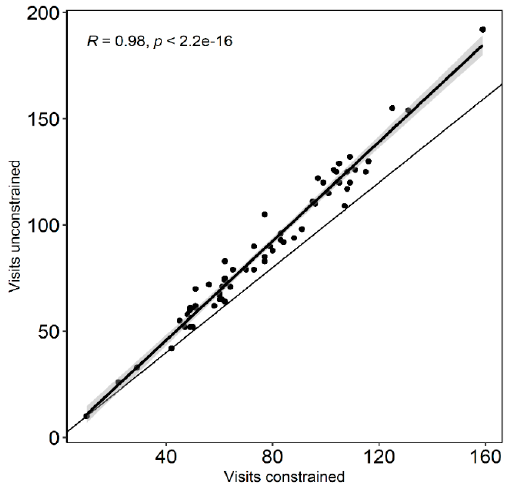
Figure A1. Relationship between total number of visits to flower-heads by hummingbirds including visits behind rocks (visits unconstrained) and the number based only on flower-head visits that could be easily seen (visits constrained). The data points are the sum of the visits recorded on the four plots per hour over each day (5) of the pollinator sampling (N = 60). The fine black line shows the 1:1 expectation.